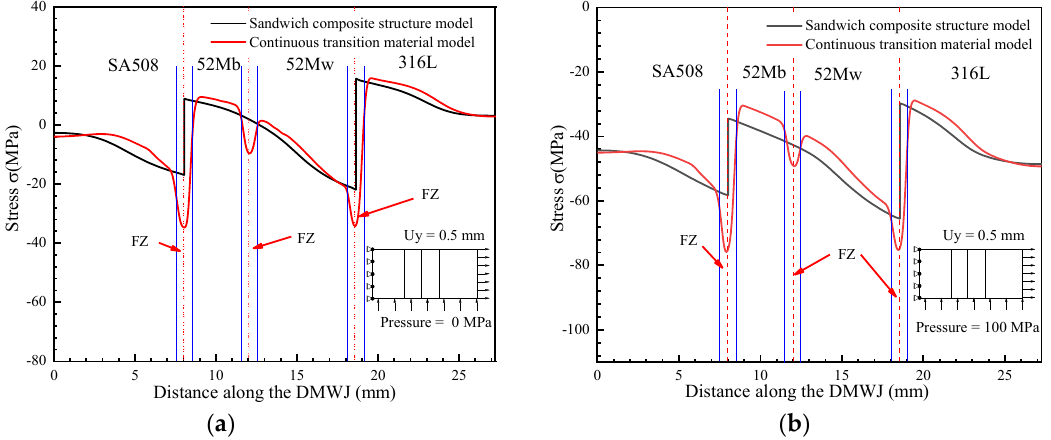
Figure 9. X -directional stress under ( a ) an axial load and ( b ) an axial load and internal pipe pressure. As shown in Figure 10, when axial loads alone were considered, the y -directional stress component was significantly larger than when both the axial and the internal pipe pressure loads were considered. This is due to the reduction of the y -directional stress component by the internal pressure. The y -directional component exhibited the same behavior under both loading conditions, with the stress in the interface region changing abruptly. This further supports the need to prioritize the mechanical properties of the interface region. Sandwich composite structure model Continuous transition material model